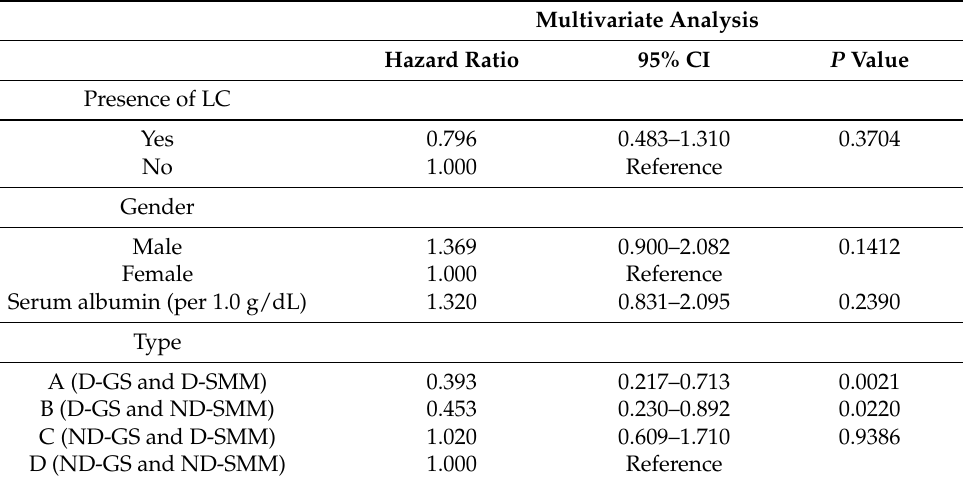
Table 4. Multivariate analyses of factors linked to PSQI-J score 6 or